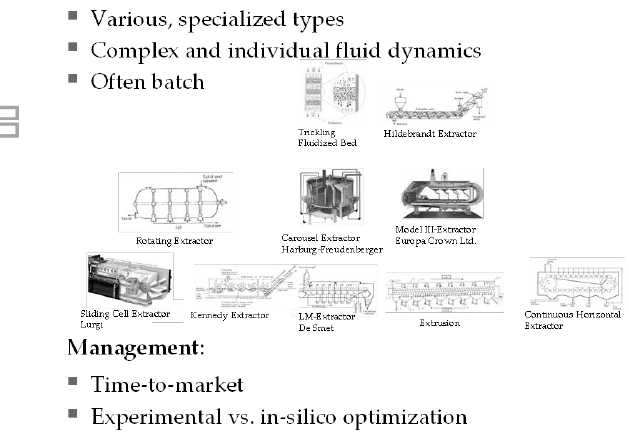
Figure 4. Need for rigorous modelling in phytoextraction, see [16] for more details on equipment.